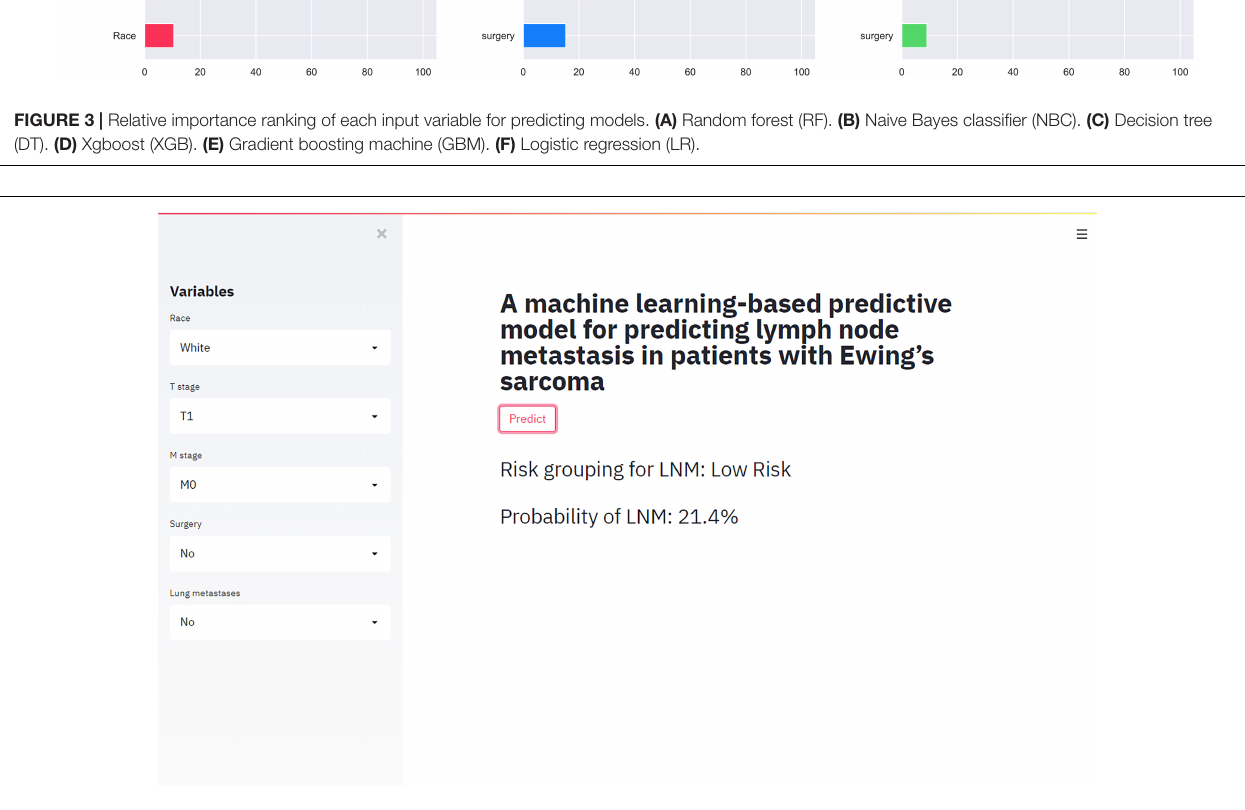
FIGURE 4 | An example of the online calculator for predicting LNM in